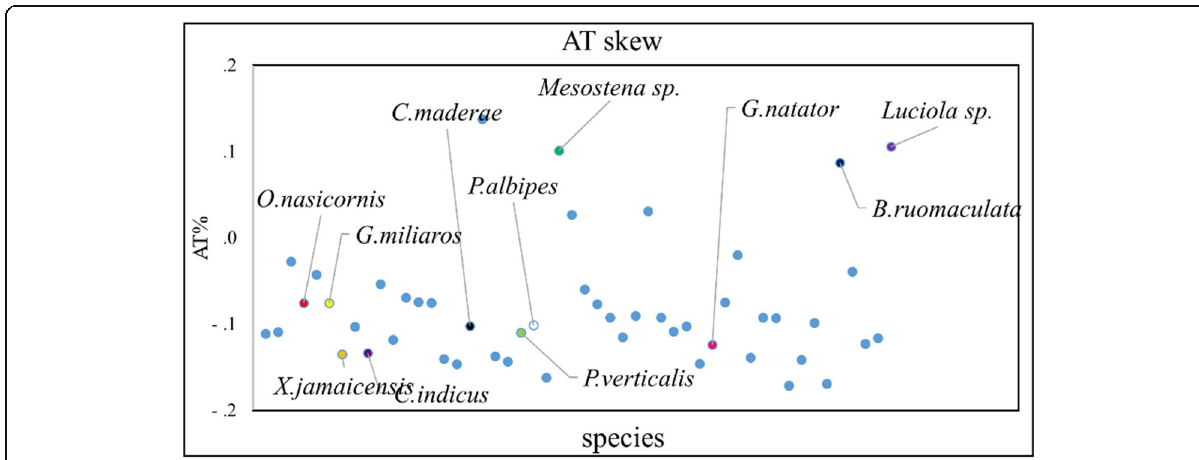
Fig. 6 AT skew of the species in study is calculated with predefined formula. The selected species sequenced are highlighted in the graph. Luciola sp. had the maximum value of + 0.1, while the lowest was of C.indicus ( − 0.13) . Mesostena sp., Luciola sp., and B.rufomaculata are the only three species having values > 0. All the rest species are less AT